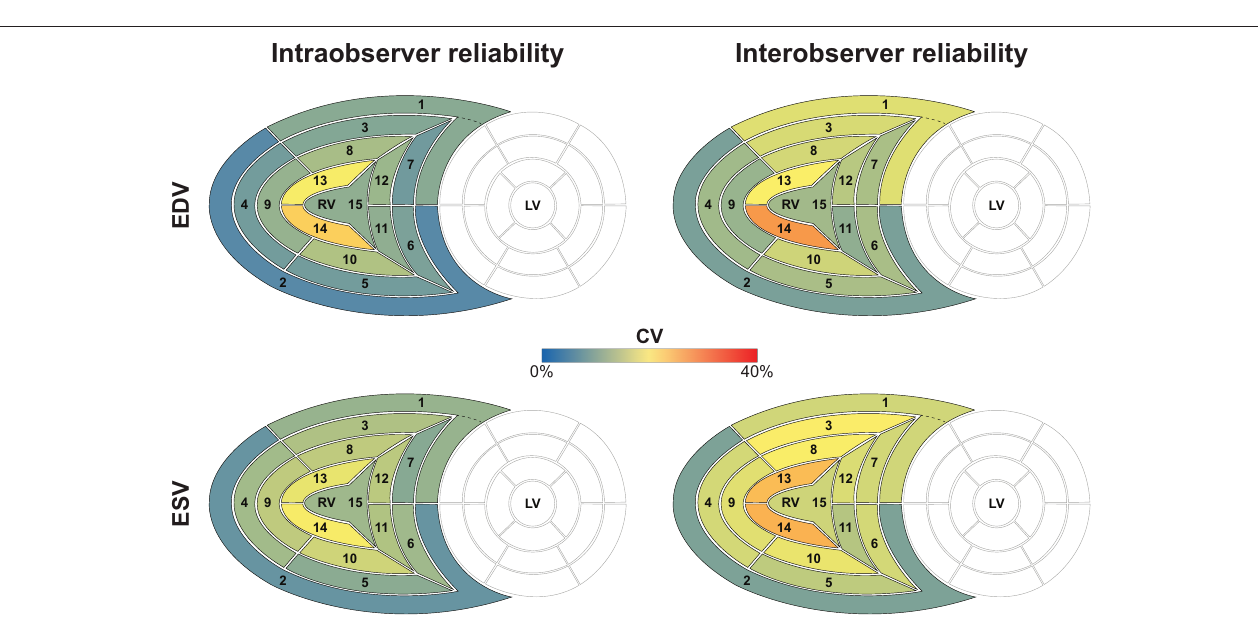
FIGURE 7 | Intra- and interobserver reliability of right ventricular end-diastolic and end-systolic segmental volumes. The 15 segments are color-coded based on the value of the coefficient of variation: reddish colors indicate a higher, whereas blueish colors correspond to a lower value of coefficient of variation. Segment numbers as defined in Figure 3 . EDV, end-diastolic volume; ESV, end-systolic volume; CV, coefficient of variation; LV, left ventricle; RV, right